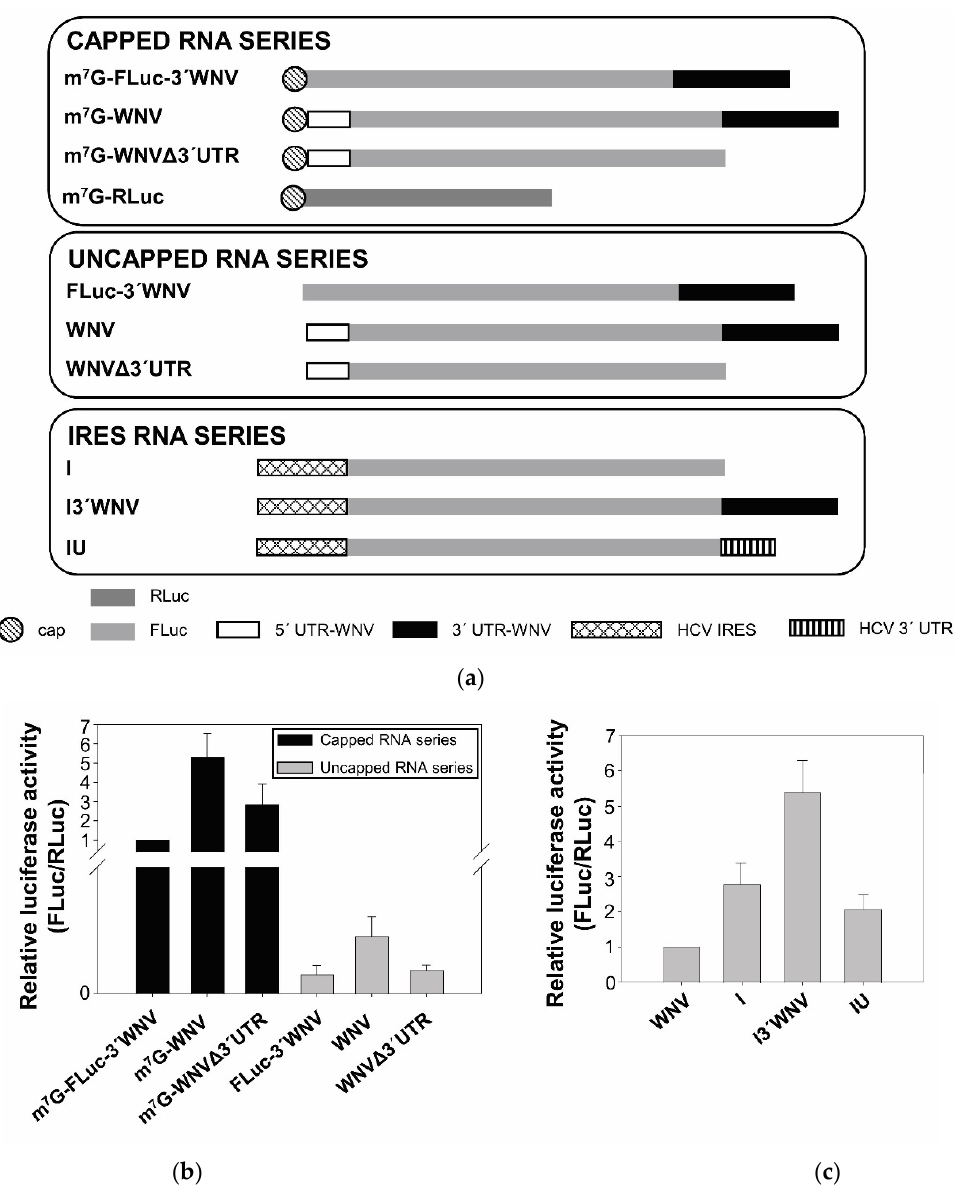
Figure 1. Cap-independent translation of WNV genome. ( a ) Diagram of the RNA constructs har- bouring the FLuc coding sequence flanked by different 5 ′ end and the 3 ′ UTR of the WNV RNA genome, and control constructs. ( b ) Translation efficiency of different capped and uncapped RNA constructs. Vero cells were cotransfected with the individual RNA constructs indicated in ( a ) and m 7 G-RLuc RNA. Translation activity was determined as FLuc protein activity normalized against the value obtained for RLuc. Values refer to that of the capped RNA coding the FLuc fusion to the WNV 3 ′ UTR (m 7 G-FLuc-3 ′ UTR). ( c ) Translation efficiency of the HCV IRES-dependent RNA con- structs. Translation activity was determined as described in ( b ); values are referred to that of the uncapped WNV construct. Values are the mean of at least three independent experiments ± stand- ard deviation.